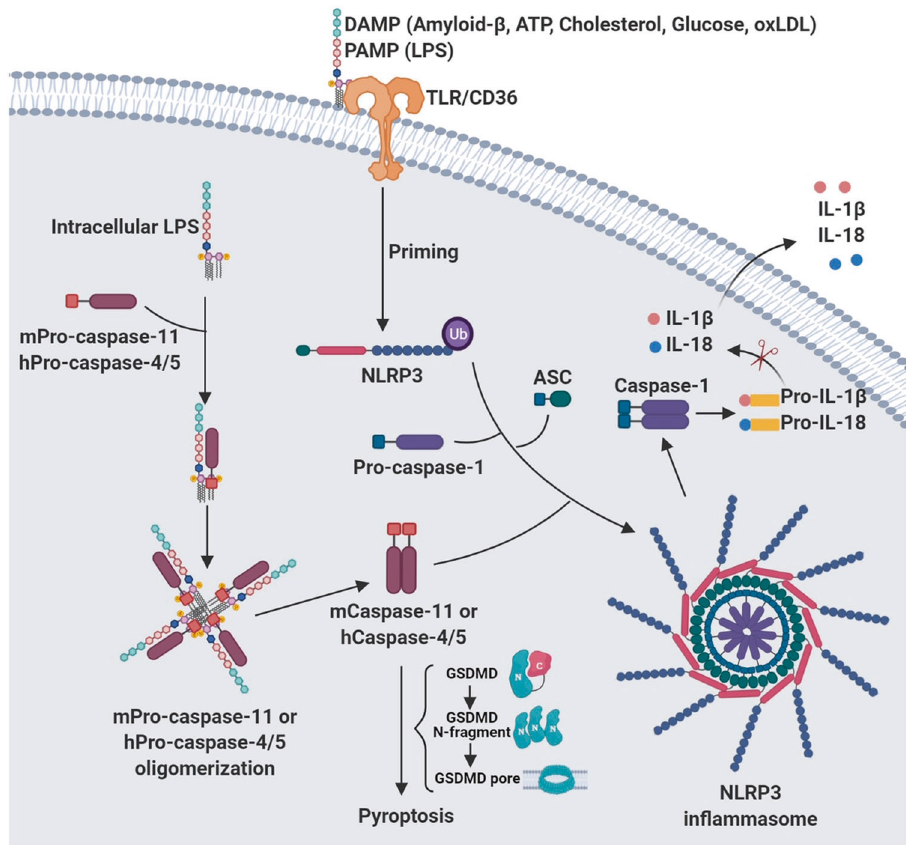
Fig. 4 Mechanisms of non-canonical in fl ammasome assembly and activation. Intracellular LPS forms a complex with pro-caspase-11 (mouse) or pro-caspases-4 and -5 (human), which become activated through oligomerization. Activated caspase-4/5/11 induces pyroptosis by cleaving intact GSDMD to generate the N-terminal fragment which forms a pore on membrane. The active mCaspase-11/hCaspase-4 is also involved in the assembly and activation of the NLRP3 in fl ammasome when PAMP/DAMP signals are